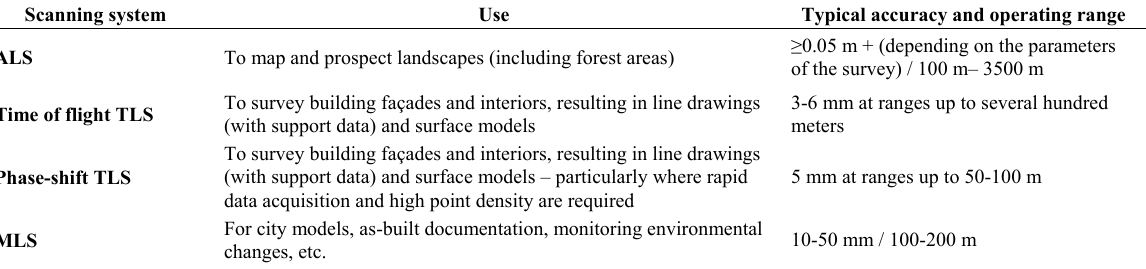
Table 3. Laser scanning techniques used in CH management activities (adapted from Barber et al.,